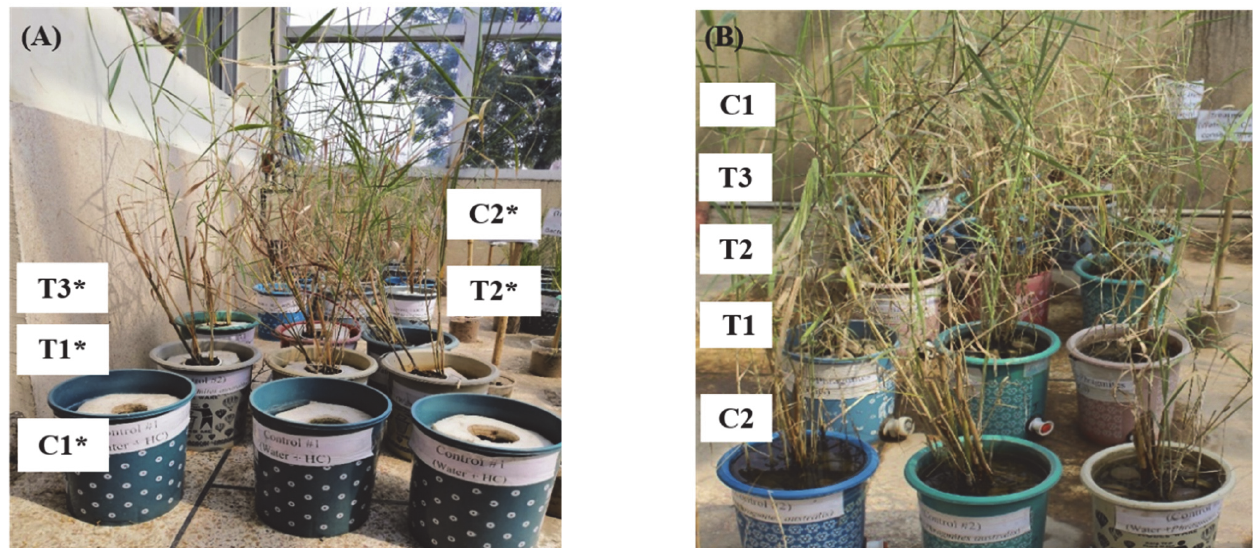
Figure 2. Development of floating treatment wetlands ( A ) and constructed wetlands ( B ) for the remediation of phenanthrene-contaminated water.